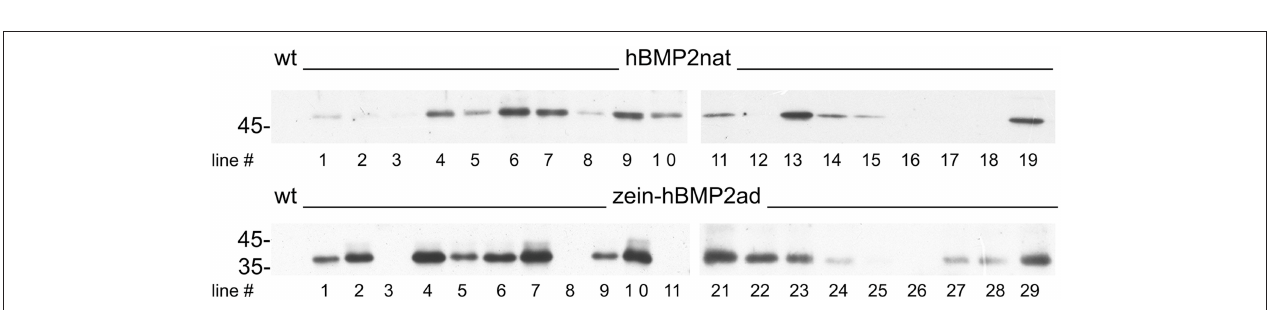
FIGURE 3 | zein-hBMP2ad accumulates to higher levels than hBMP2nat in transgenic plants. Leaves (0.5g, fresh weight) from independent transgenic tobacco plants expressing hBMP2nat (upper panel, lines 1–19), zein-hBMP2ad (lower panel, lines 1–11, 21–29) or untransformed plants (wt), were homogenized in Laemmli buffer at 95 ◦ C (ratio 7:1). Twenty-five microliters of leaf homogenate from each sample (corresponding to 12.5 µ g of total leaf proteins) were subjected to SDS-PAGE, followed by protein blot analysis with anti-Flag antiserum. Protein blot exposure time: hBMP2nat, 15min; zein-hBMP2, 1min. Numbers on the left indicate the position and size (in kDa) of molecular mass